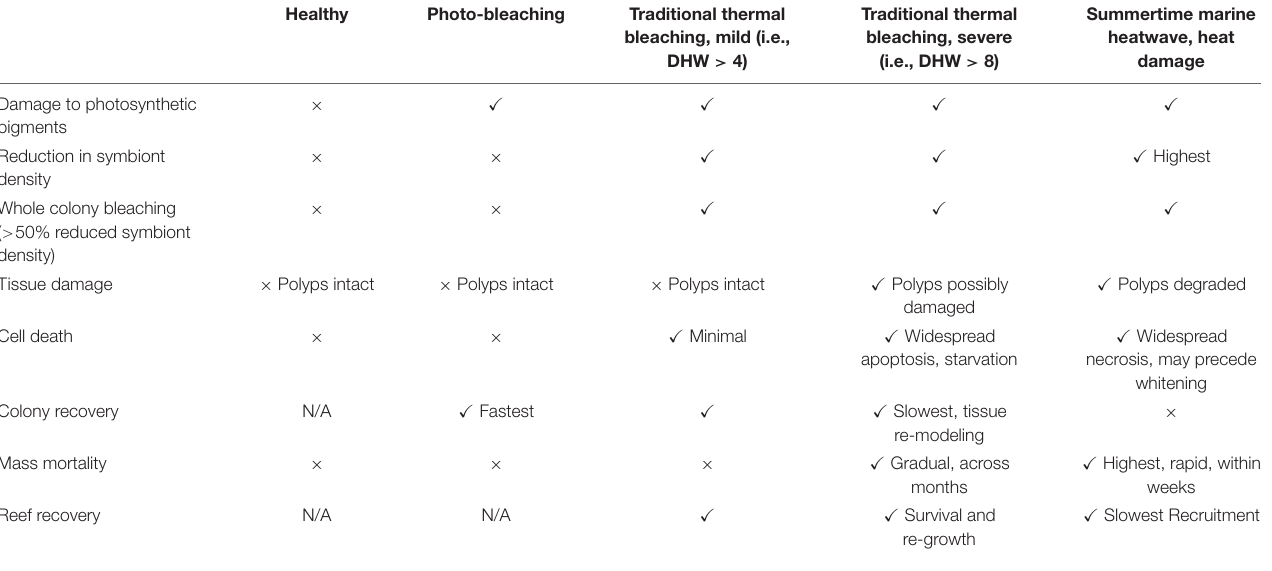
TABLE 3 | The range of ecological and physiological responses of corals to varying degrees of environmental stress. Healthy Photo-bleaching Traditional thermal bleaching, mild